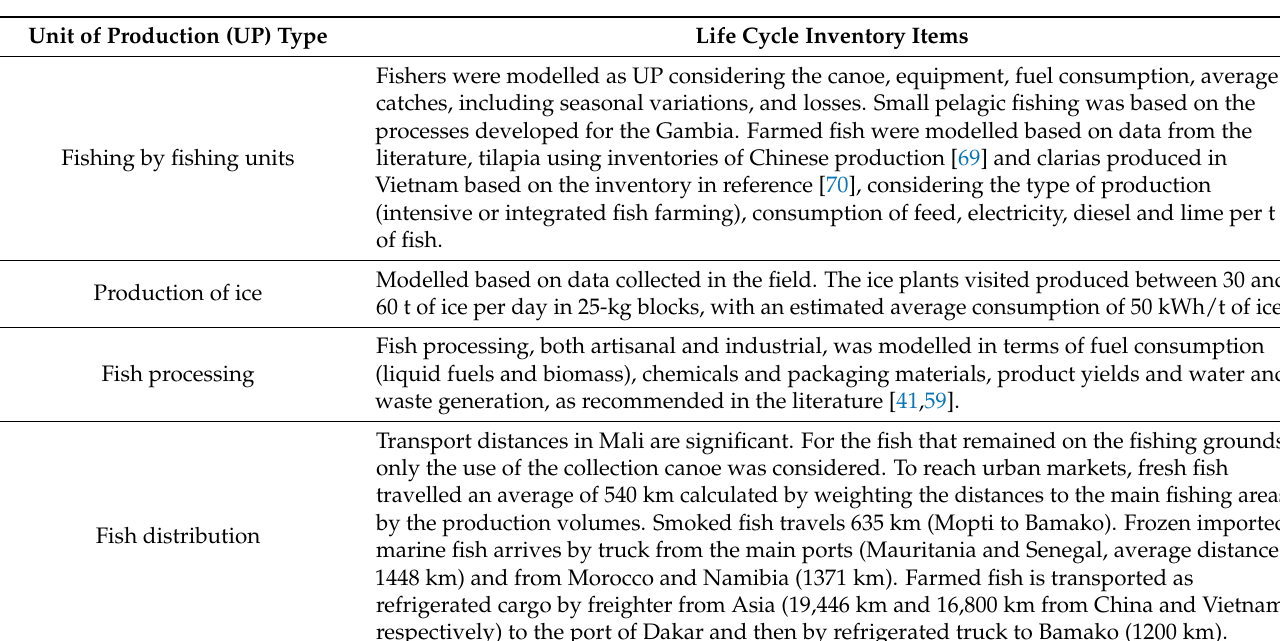
Table 2. Life cycle inventories by the type of unit of production of the Malian fisheries value